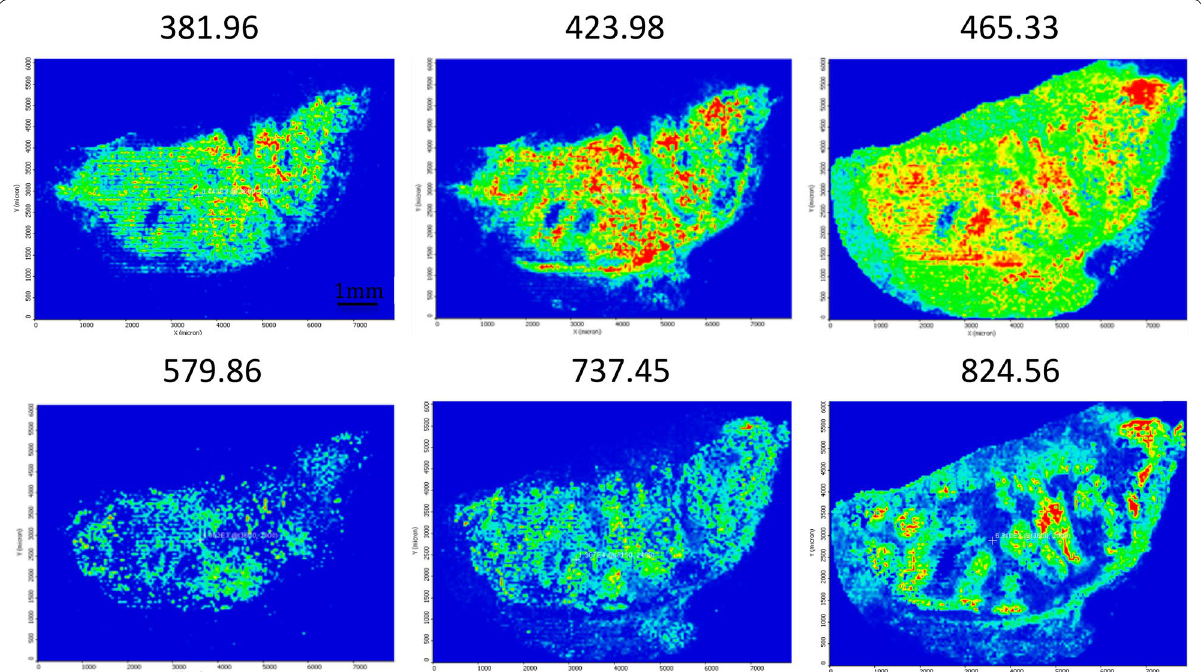
Fig. 3 MALDI images from melanoma tissue samples isolated after surgery within a m/z range 100–1000. The scale bar represents 1